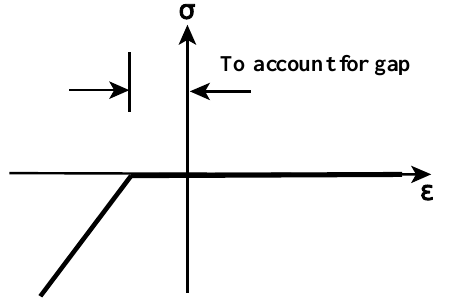
Fig. 1. Stress-strain relationship of contact/gap